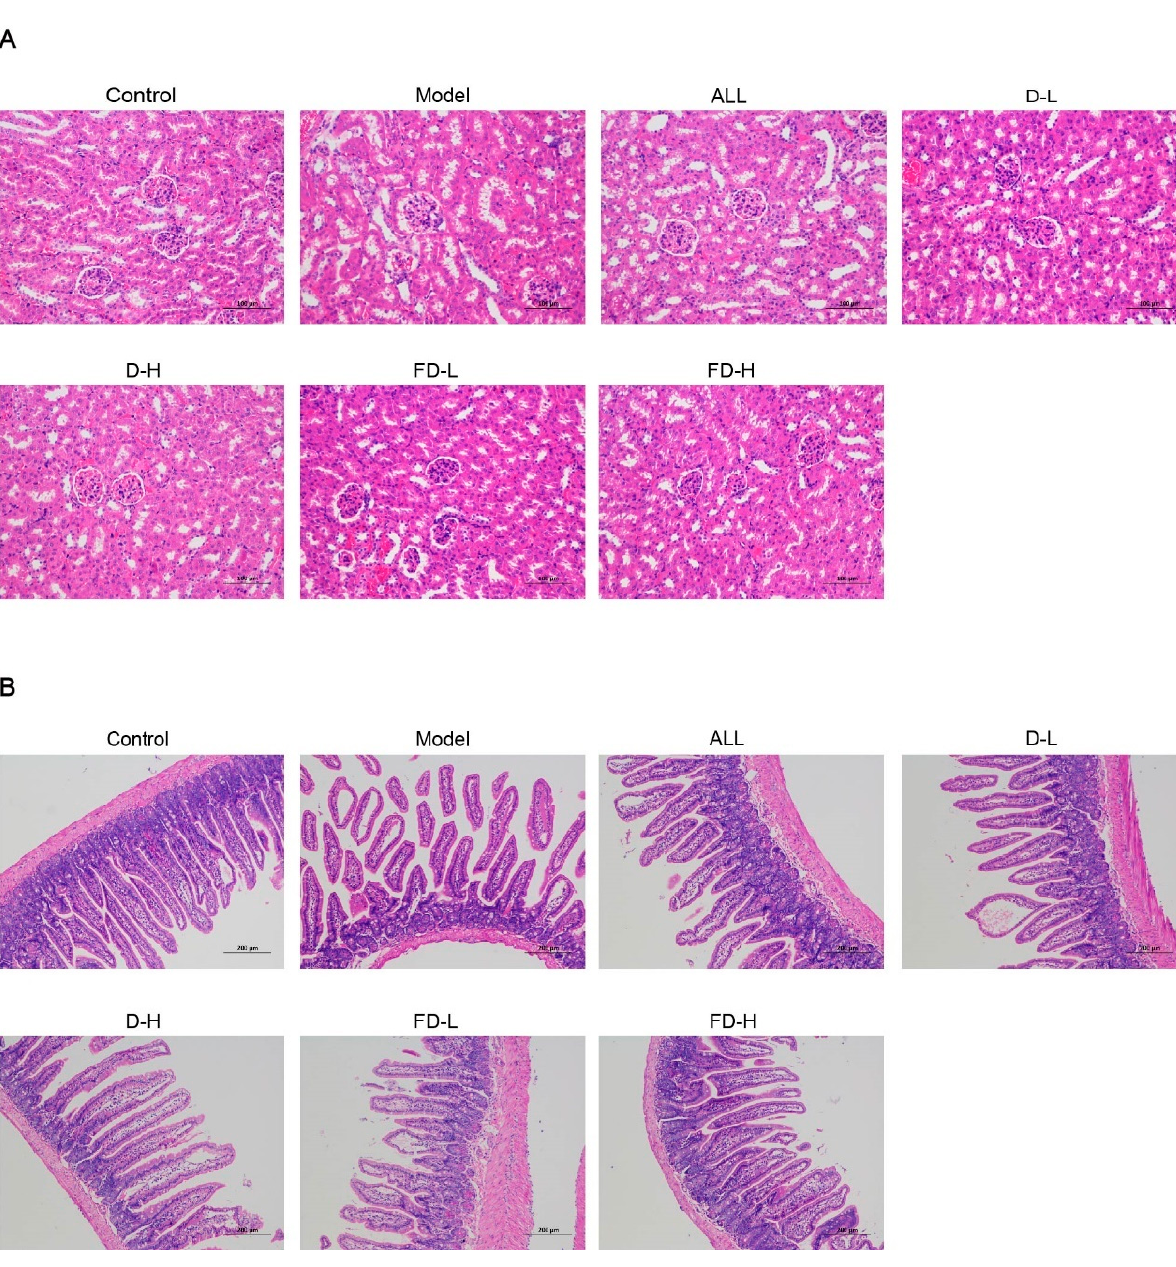
Figure 5. Effects of fermented dandelion on kidney and ileum of mice with HUA. ( A ) Renal patho- logical section (200×). ( B ) Pathological section of the small intestine (100×). ALL, allopurinol; D-L, dandelion low dose group; D-H, dandelion high dose group; FD-L, low dose group of LAFD; FD-H, high dose group of LAFD.